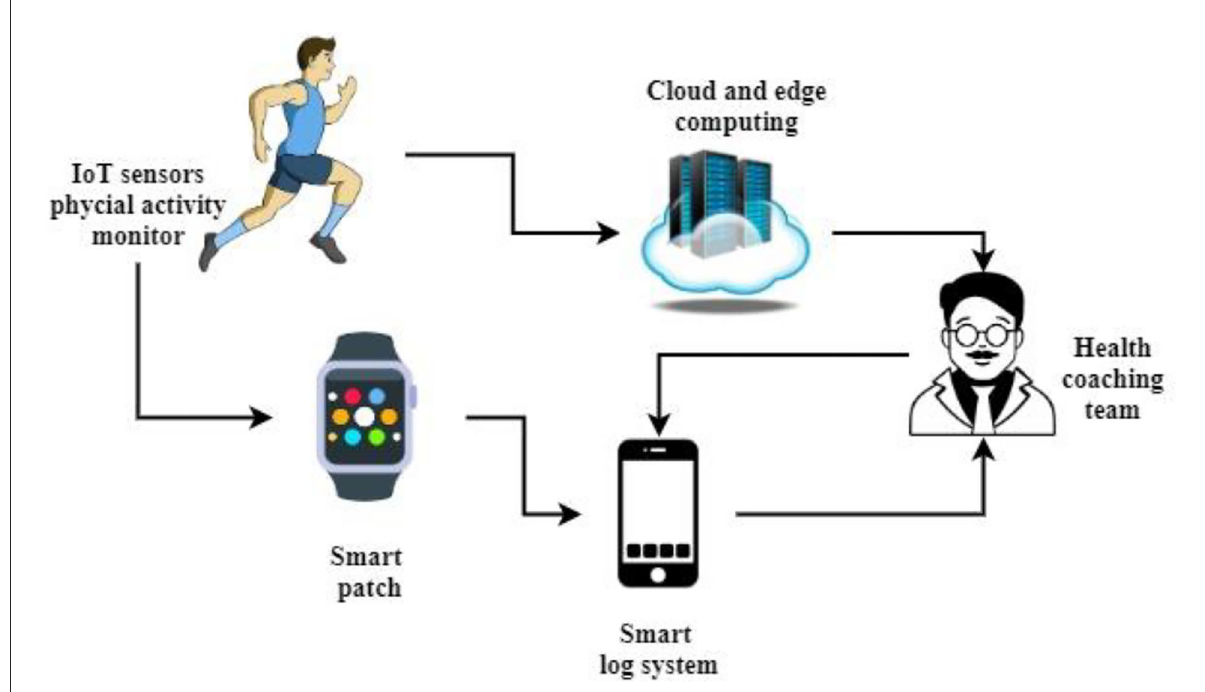
FIGURE1 The architecture of the proposed intelligent m-Health monitoring system